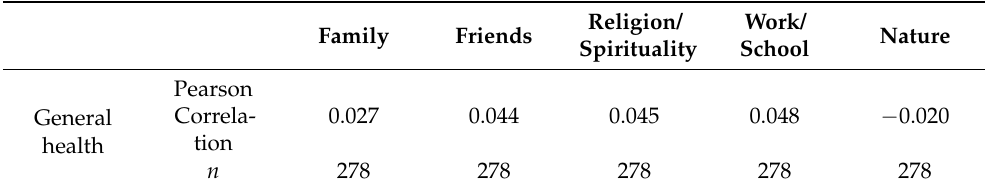
Religion/ Work/ Nature Spirituality School